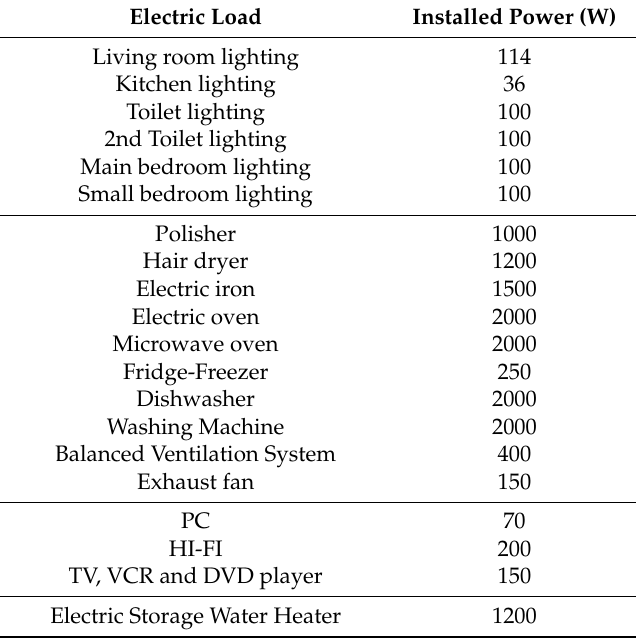
Table 2. Electric loads in the apartment.